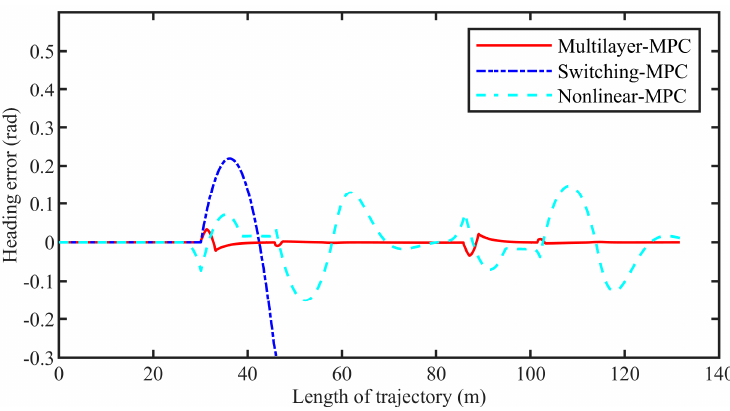
Figure 8. Displacement error of the comparison between controllers.